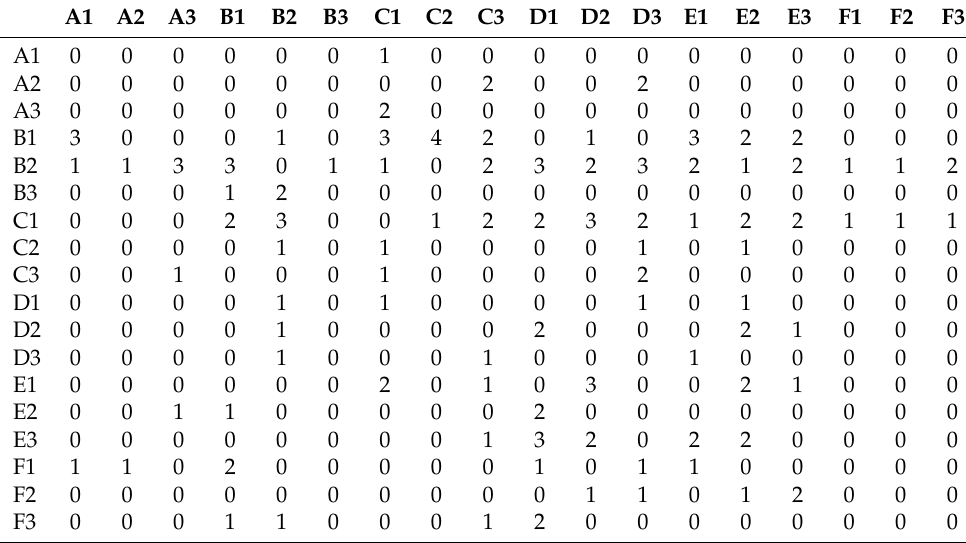
Table 4. The initial fuzzy direct relationship